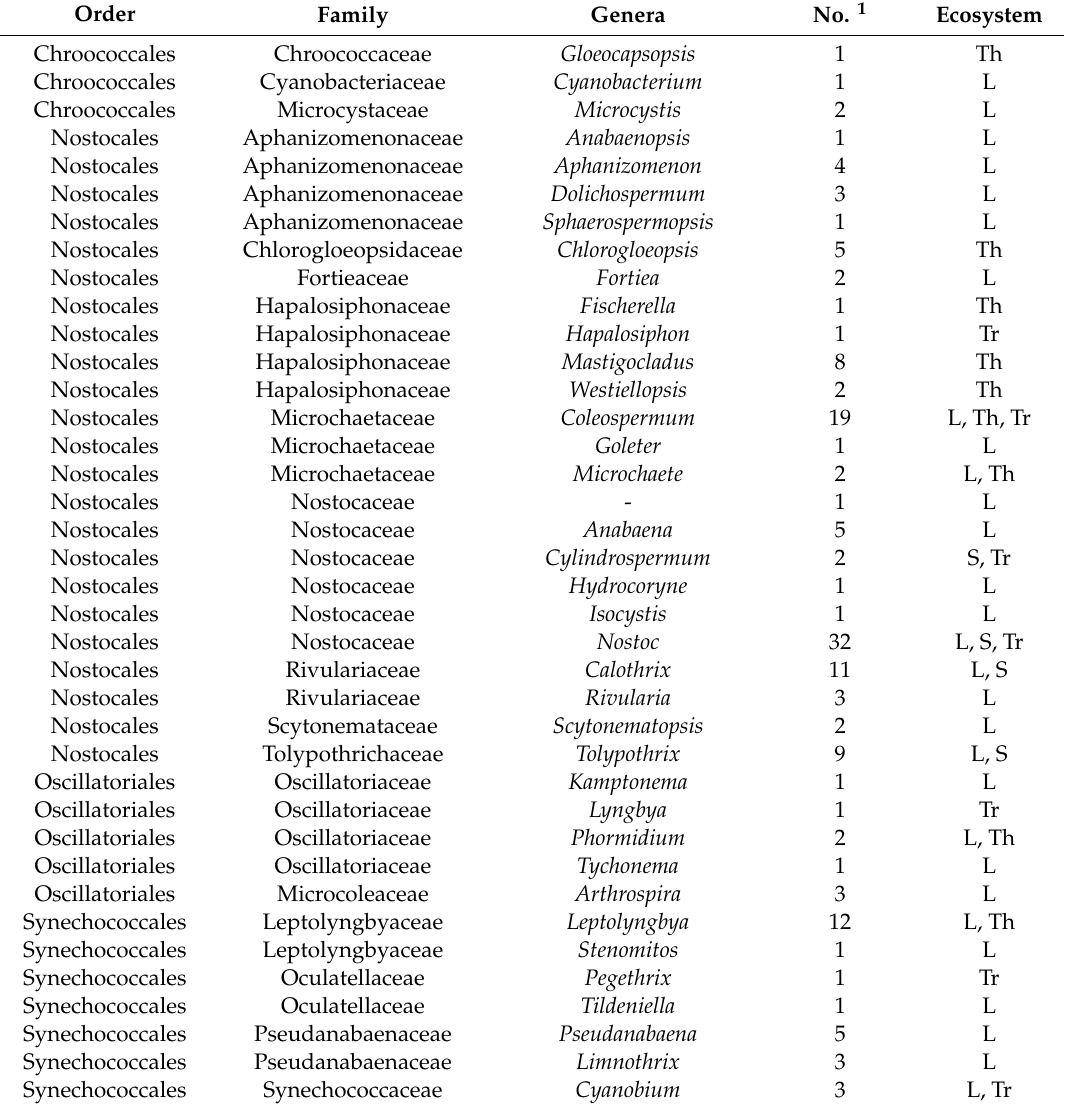
Table 1. Isolated cyanobacteria (number) by order, family, and genera. Strains isolated from di ff erent types of